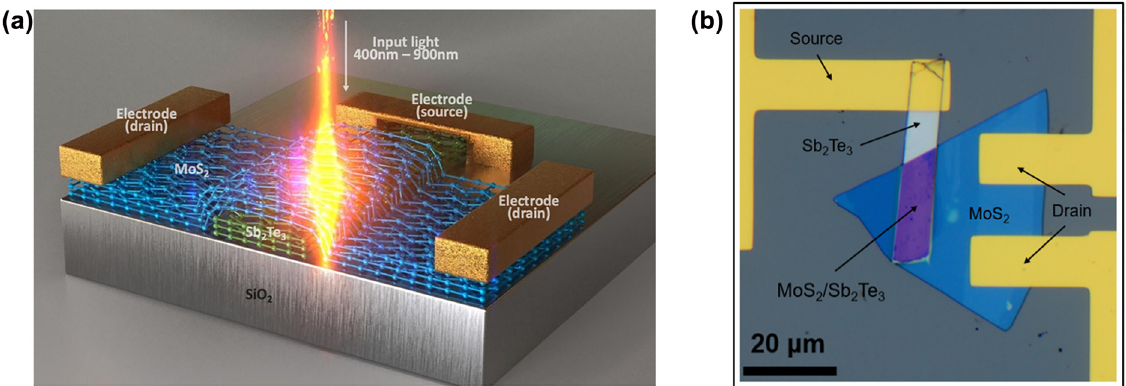
Te /MoS pn junction heterostructure photodetector. (a) A schematic representation of the Sb Figure 1: Sb 2 3 2 junction photodetector. (b) The optical microscope image of PN junction device.